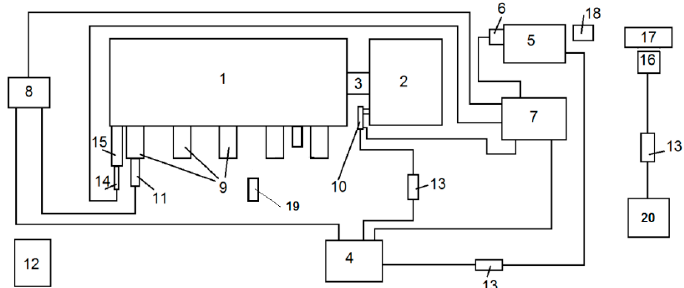
Figure 4. The scheme of test track: 1—combustion engine, 2—generator, 3—the shaft connecting the engine and generator, 4, 13, 14—power supply, 5—laptop, 6—analog to digital converter, 7— terminal connection, 8—amplifier, 9—indicator valves, 10—photo optical crankshaft position sensor, 11—resistance pressure sensor, 12—ambient parameter meter, 15—pressure sensor in injection subsystem, 16—camera, 17—engine load indicator, 18—monitor, 19—non-contact temperature meter, 20—antenna.